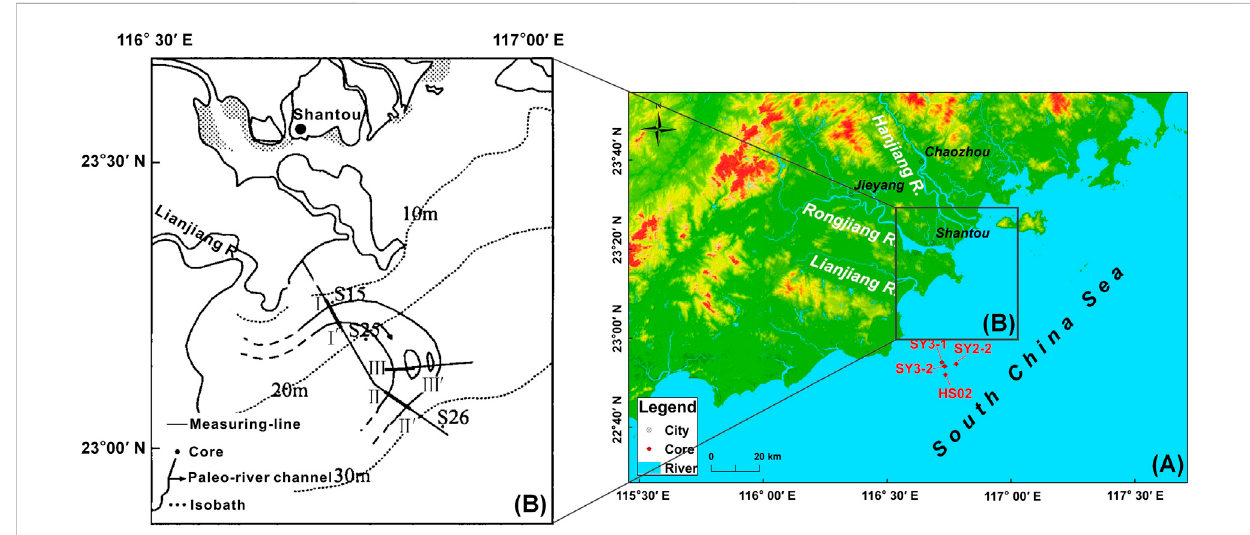
FIGURE 7 (A) The major area of Lianjiang River plain and its southeastern neritic area in this study. (B) Location of the paleo-river channel of paleo Lianjiang River in the neritic area of the modern Lianjiang River mouth, modi fi ed from Liu et al.